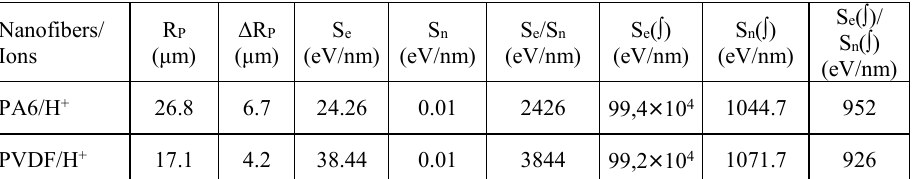
Table. 2. Data obtained from SRIM: R P is the projected range of H + 1MeV ions, ΔR P is the standard deviation of the ion depth distribution , S e is the value of electronic stopping at the surface for a given polymer and S n is the value of nuclear stopping, S e /S n is the ratio between electronic and nuclear stopping at the surface, S e ( ∫ ) is integral value of electronic stopping in the whole penetrated volume, S n ( ∫) is the value of nuclear stopping in the whole penetrated volume and S e ( ∫)/S n ( ∫) is the ratio between electronic and nuclear integral stopping.